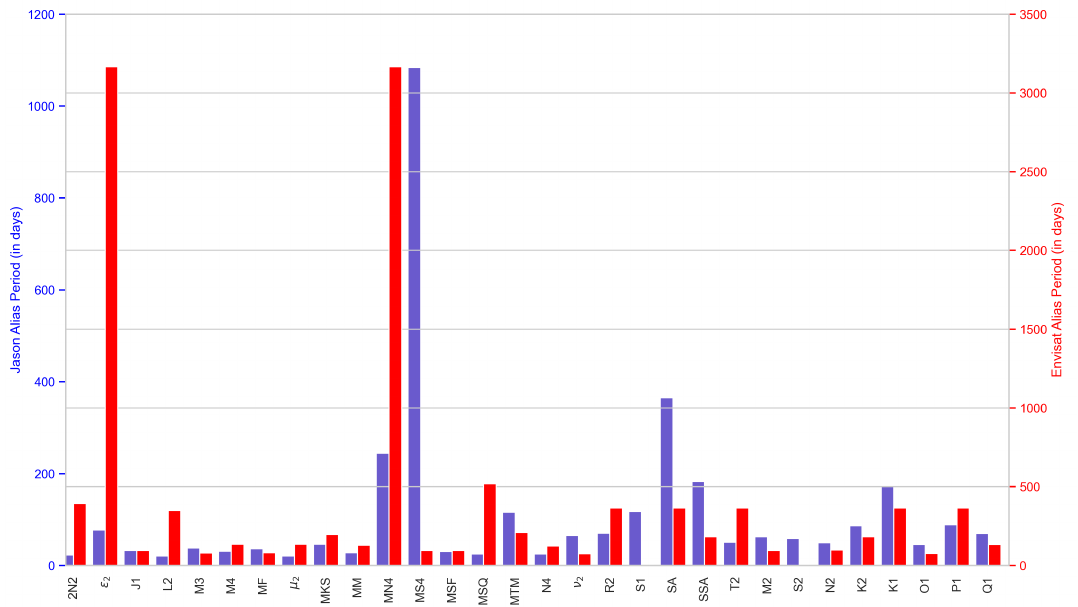
Figure 1. The L2 tidal amplitude for ( a ) EOT-R, ( b ) Inferred from EOT20, ( c ) TiME and ( d ) FES2014 compared to the L2 amplitudes from the tide gauge observations (circles).